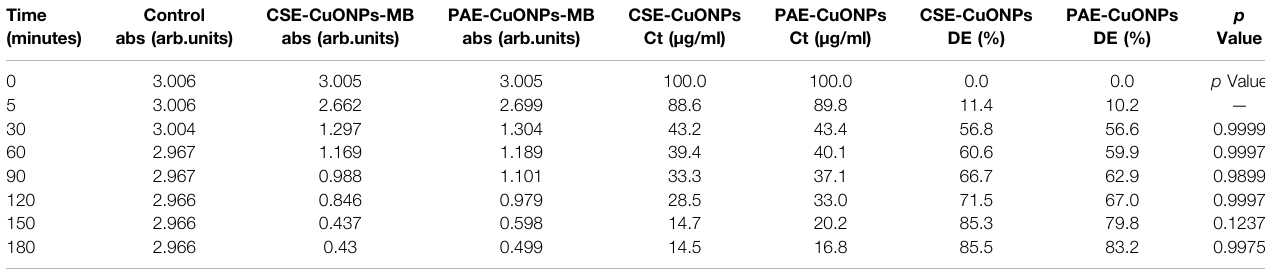
TABLE 5 | Concentration of methylene blue and degradation ef fi ciency after CuONPs photocatalysis calculated from absorbance at different time intervals. Time Control (minutes) abs (arb.units)